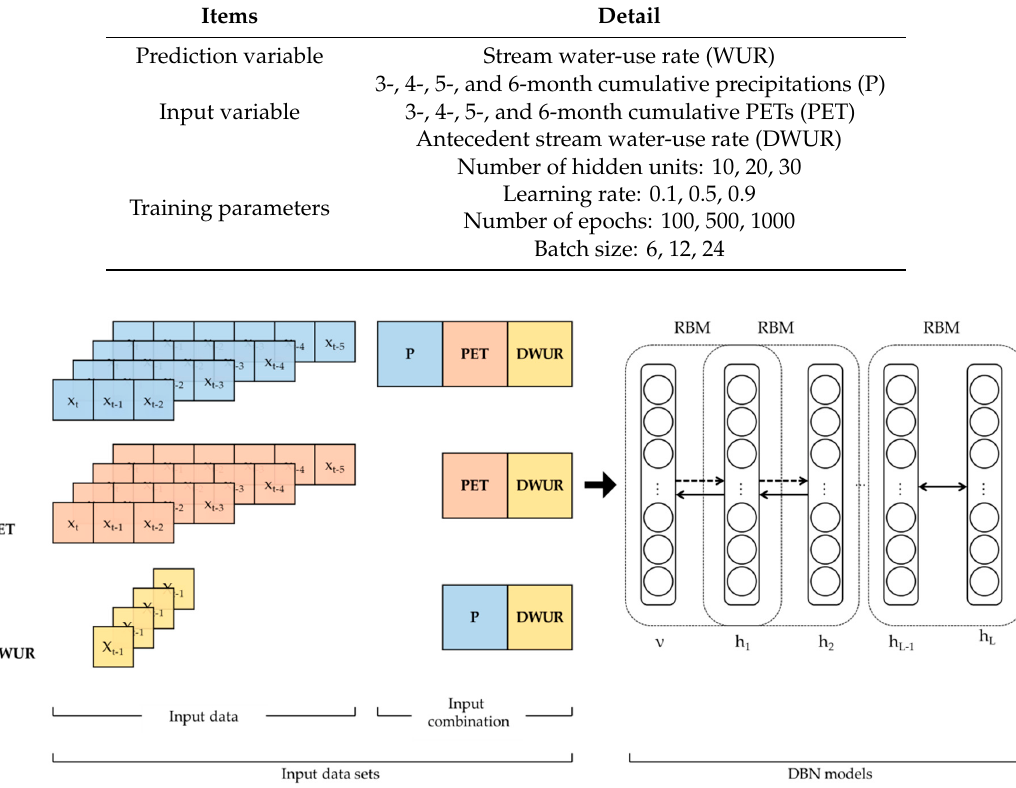
Figure 4. Proposed deep belief network configuration.